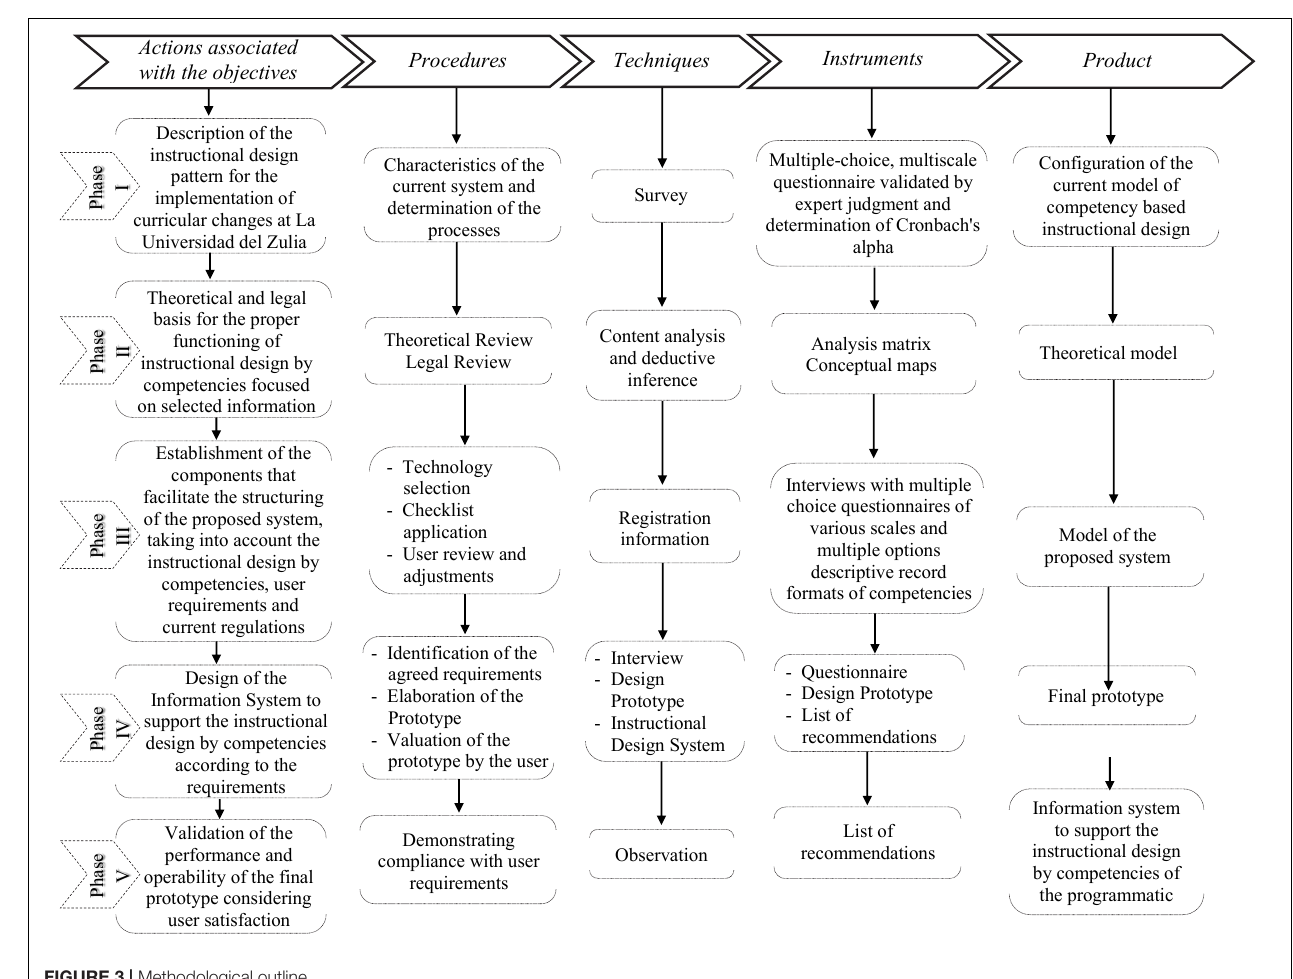
FIGURE 3 | Methodological